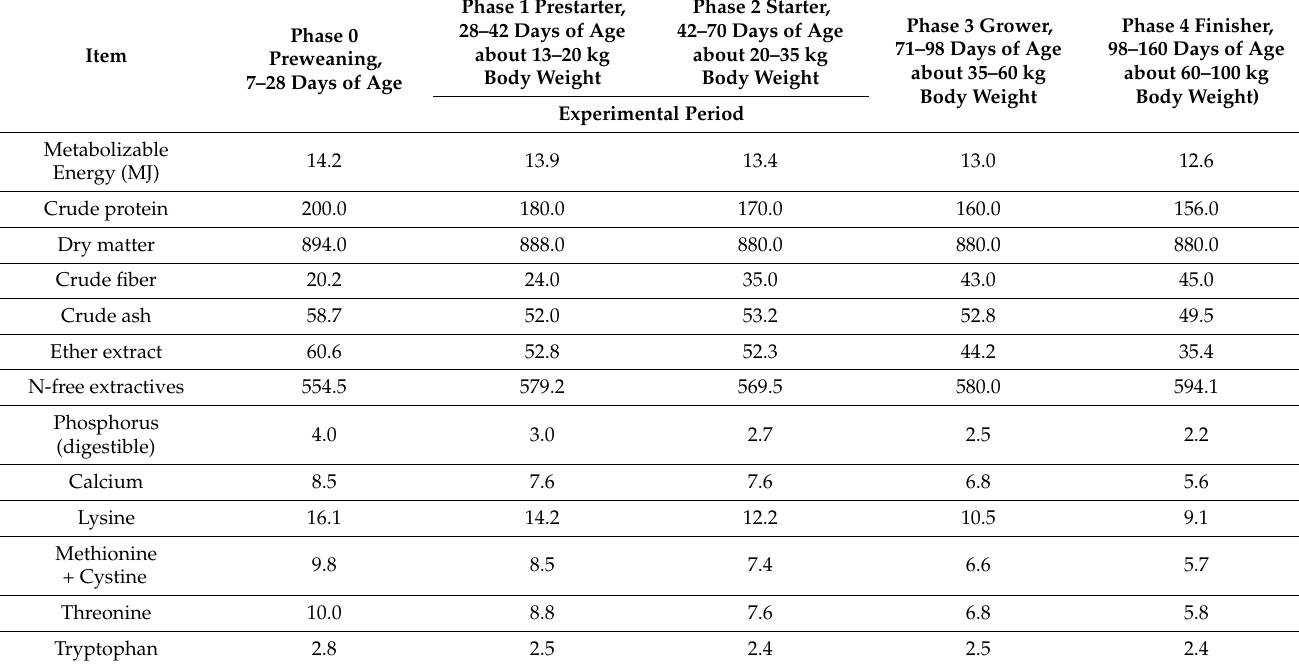
Table 2. The nutritional value of the pigs’ feed mixtures (as-fed